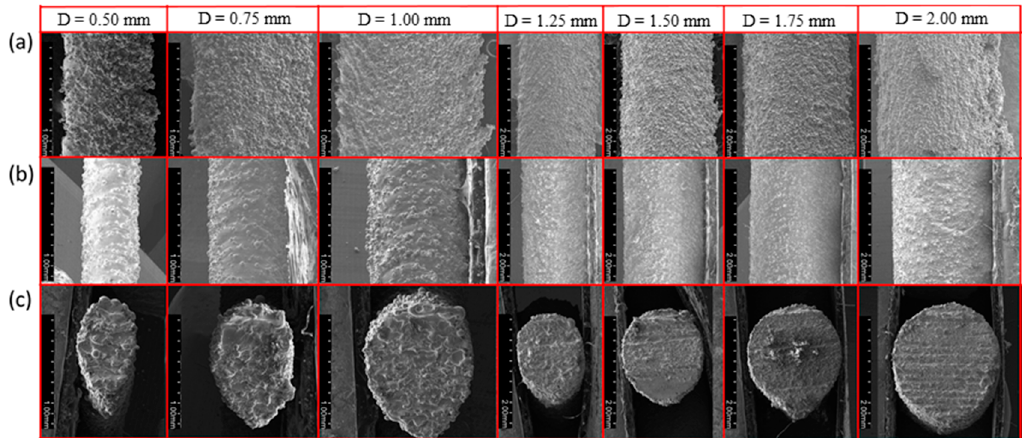
Figure 5. RA sample SEM image for inclination angles of 30° and the design diameters of 0.25–2.00 mm in increments of 0.25 mm: ( a ) taken from the horizontal direction; ( b ) taken from a vertical direction; and ( c ) taken from the cross section.